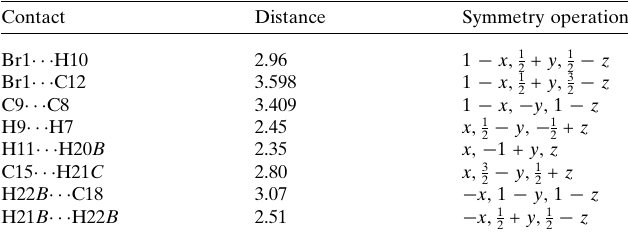
Table 2 Summary of short interatomic contacts (A˚ ) in the title compound. Contact